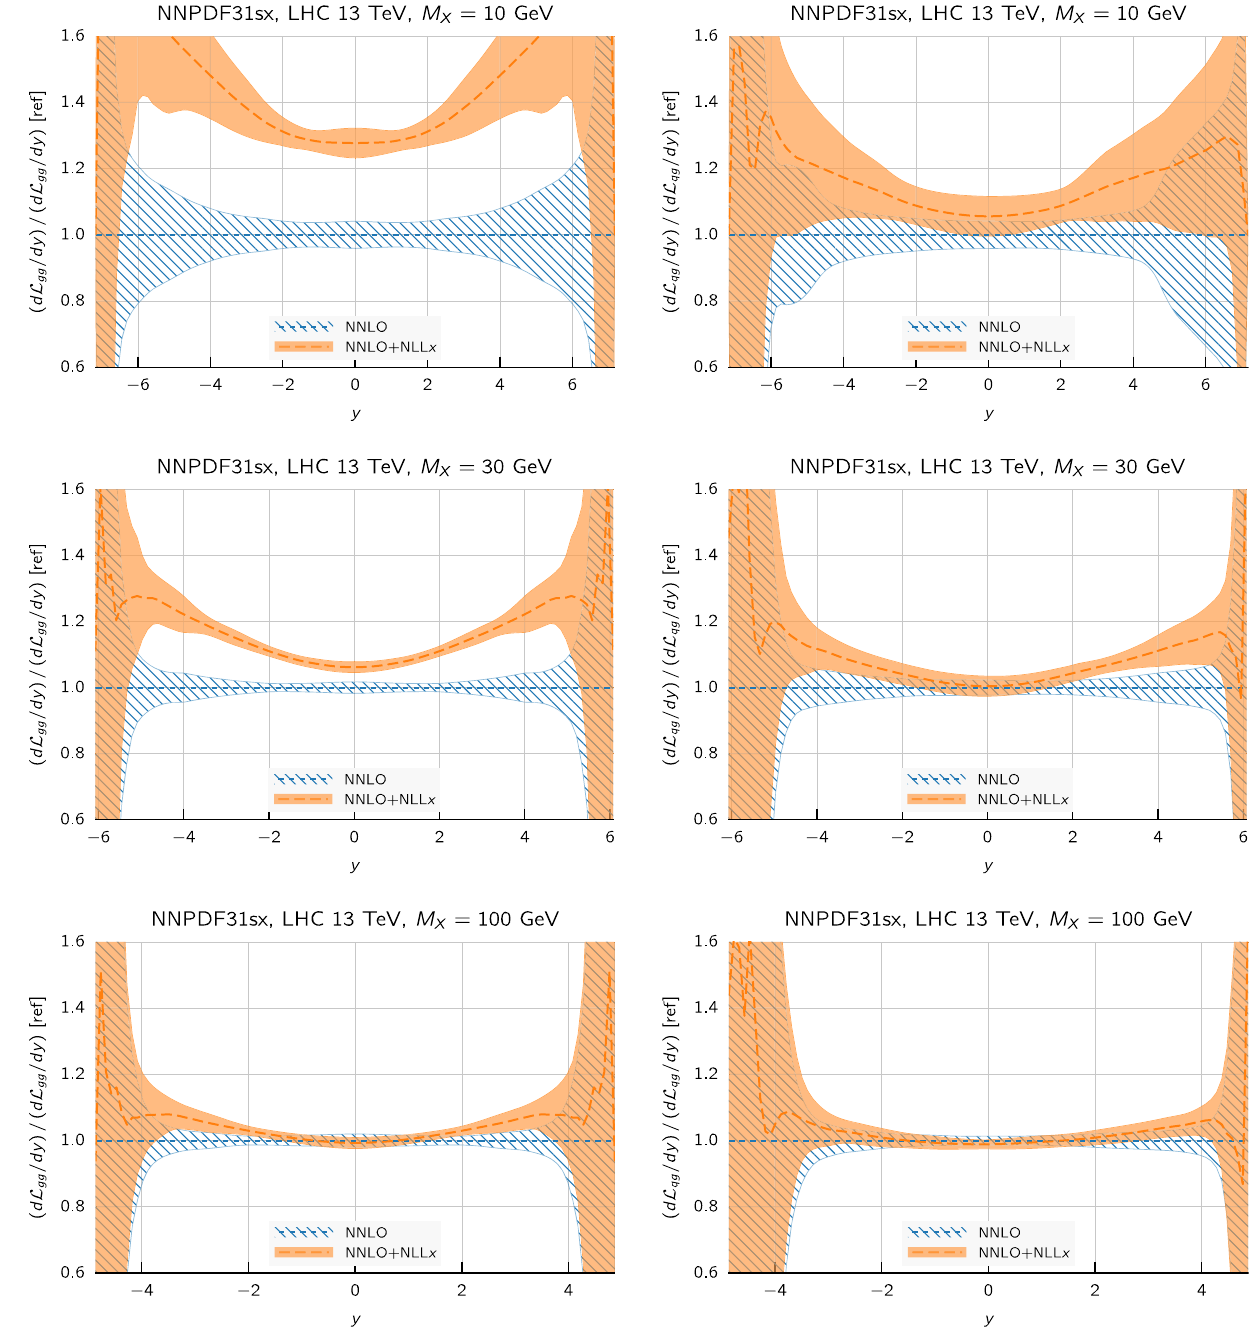
Fig. 31 The double-differential PDF luminosities as a function of μ = M X and y , Eq. (6.1), comparing the gluon–gluon (left plots) and quark–antiquark (right plots) luminosities between the NNLO and